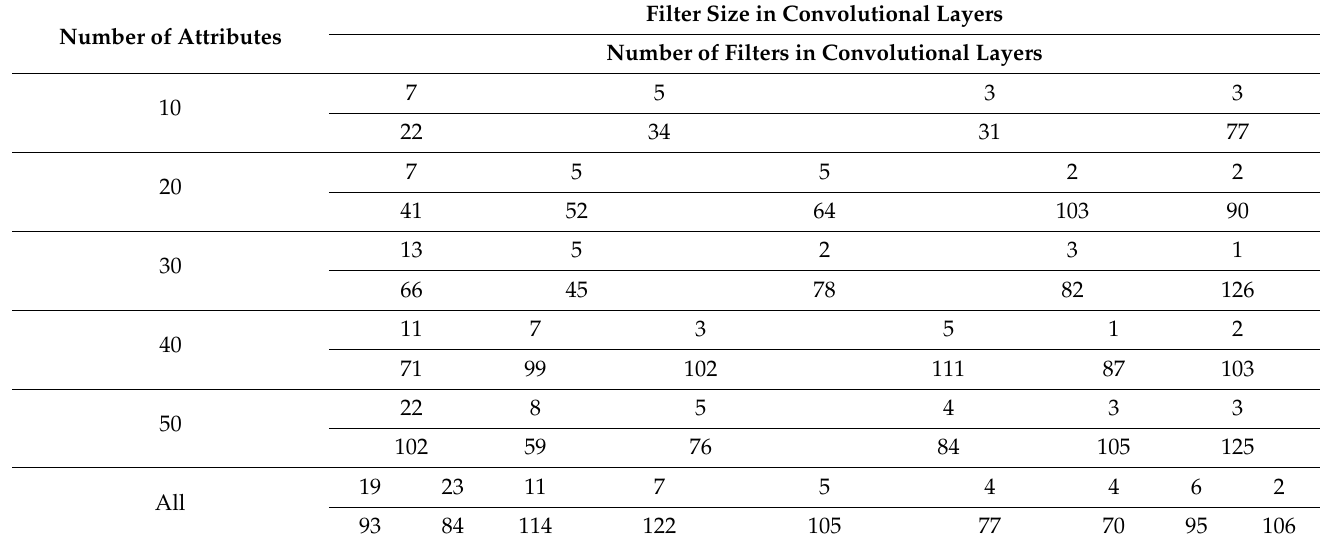
Table 4. Filter parameters of each convolutional layer for cancer stage classification. (Illustrations by the